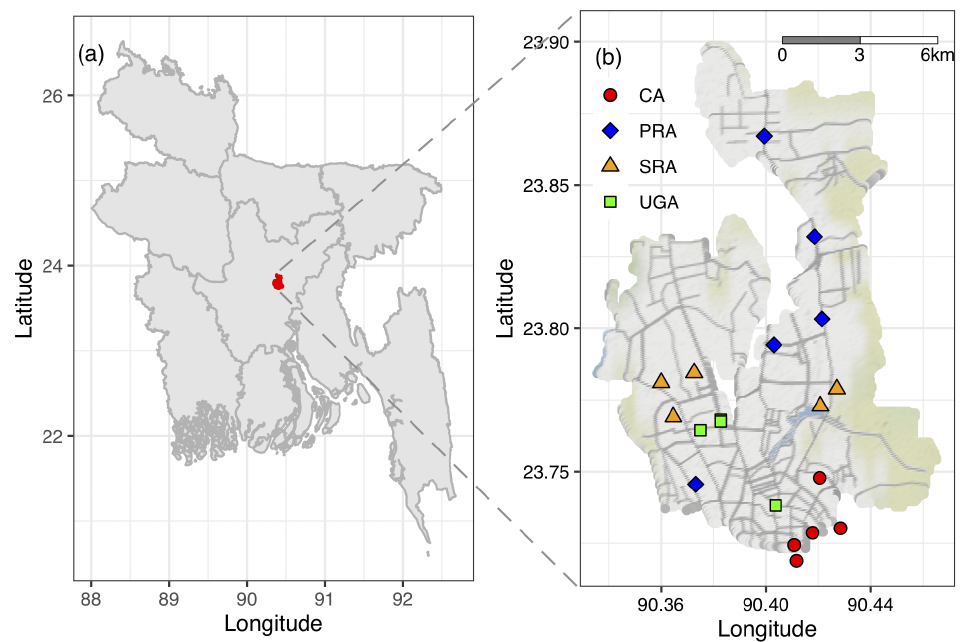
Figure 1. ( a ) Location of the study site (Dhaka city; red marked area) in Bangladesh map, and ( b ) map of Dhaka metropolitan area with different land-use categories. CA = commercial area, PRA = planned residential area, SRA = spontaneous residential area, and UGA = urban green